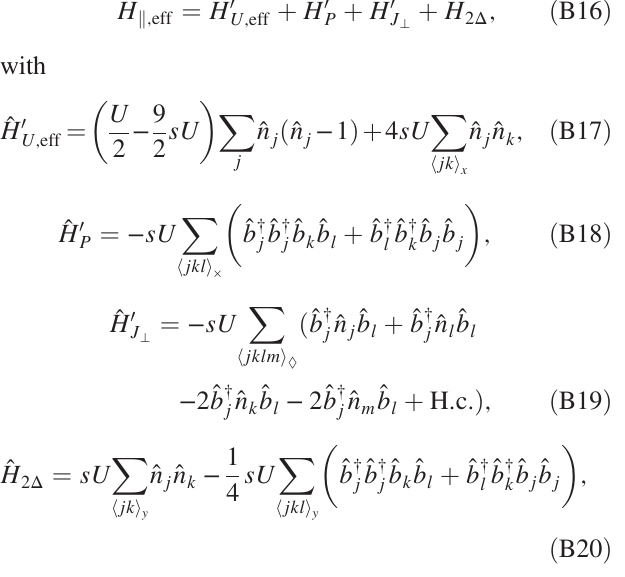
pair tunneling steps ¼ 1 in blue up to steps